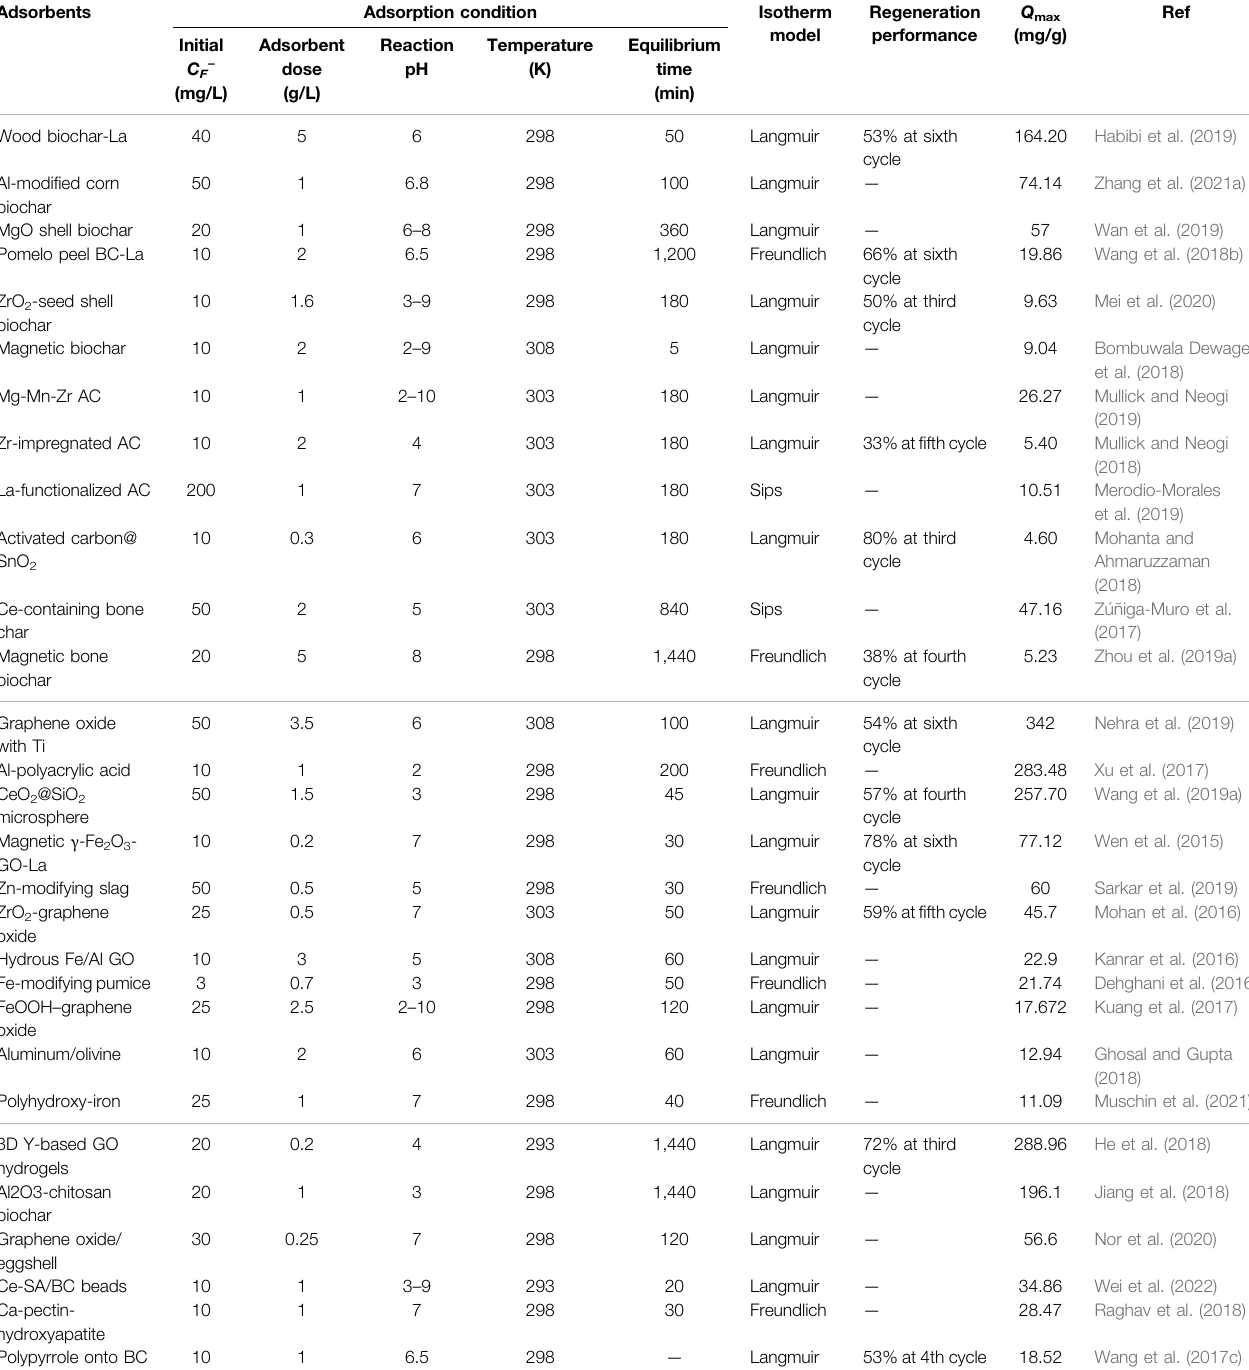
TABLE 6 | Adsorption conditions and performance of fl uoride by metal-modi fi ed carbon and other